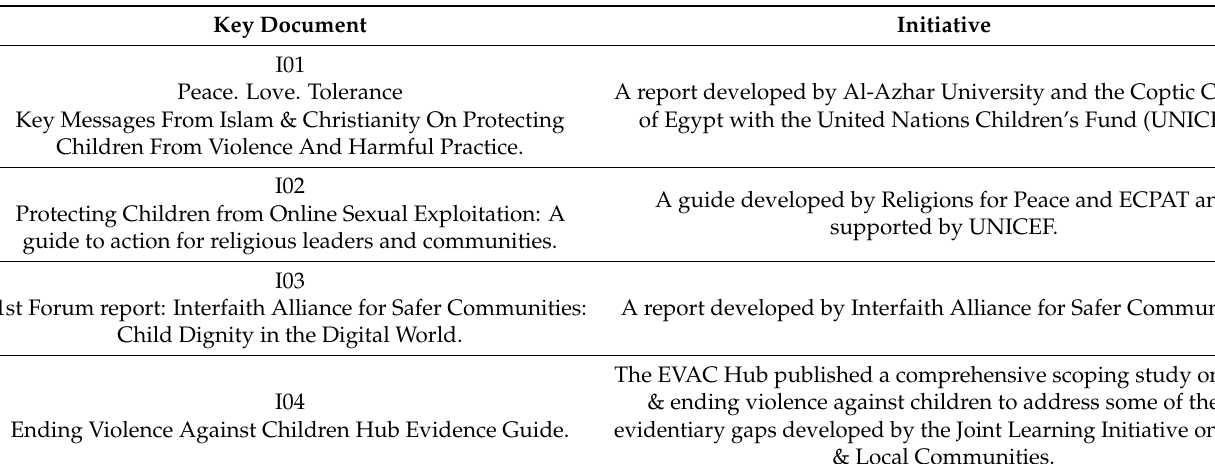
Table 1. Key documents of the initiatives